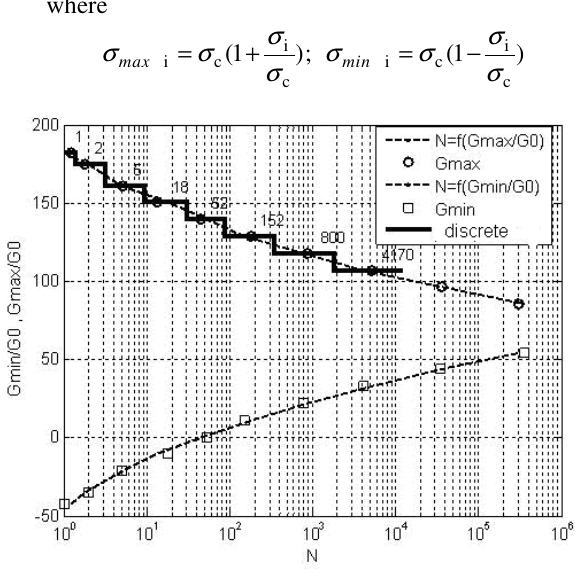
Fig. 2. Continuous and discrete loading